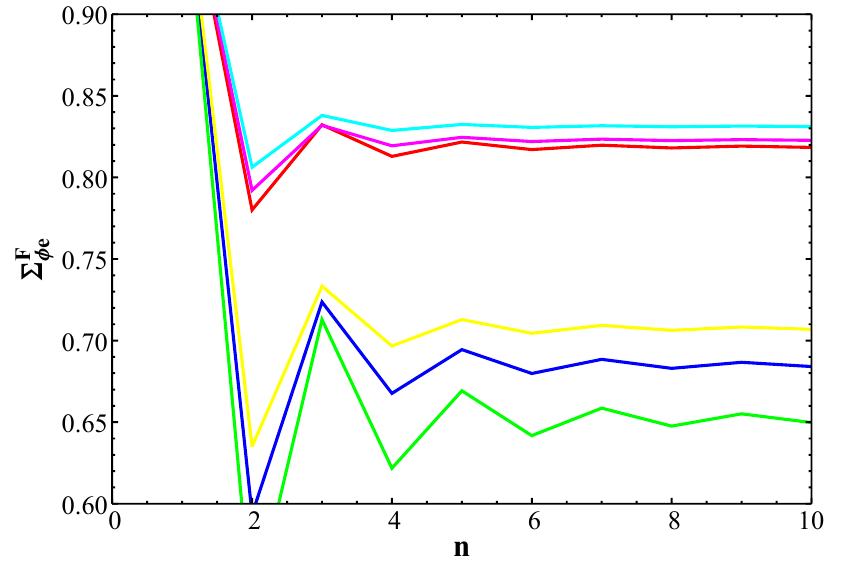
Figure 8 . The explicit KK sum form of Σ F defined in eq. (3.12), which encapsulates the depen- φe dence of the DM-electron scattering cross section on parameters of the model of the extra dimension, where only terms coming from the first n KK modes are included in the sum, for the choices of ( τ, a F ) =(1/2,1/2) [red], (1/2,1) [blue], (1/2,3/2) [green], (1,1/2) [magenta], (3/2,1/2) [cyan] and (1,1) [yellow],